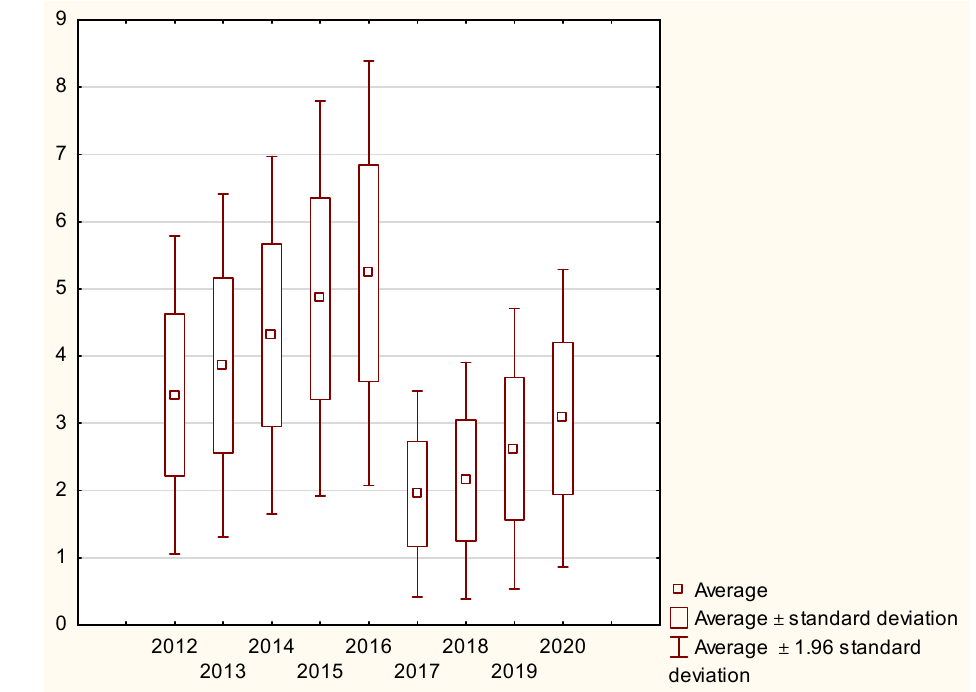
Figure 4. Box-plot for variability of bike road lengths per 10,000 inhabitants in following years.